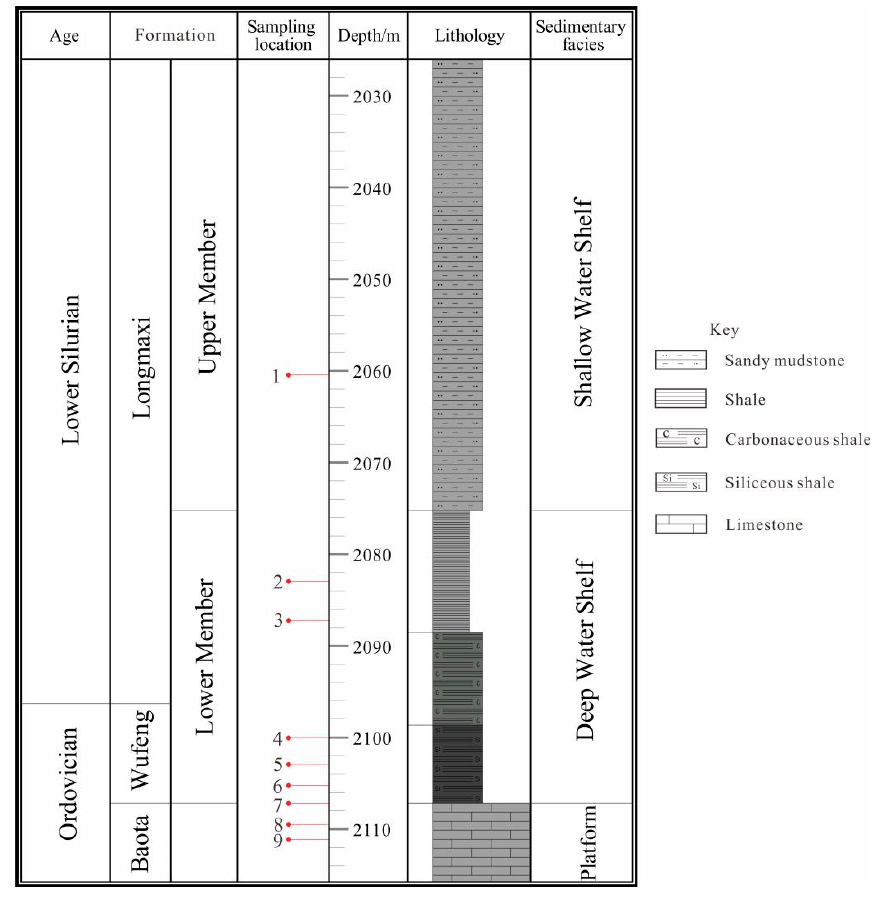
Figure 3. Geological drilling histograms of the Wufeng-Longmaxi Formations from well SY3.